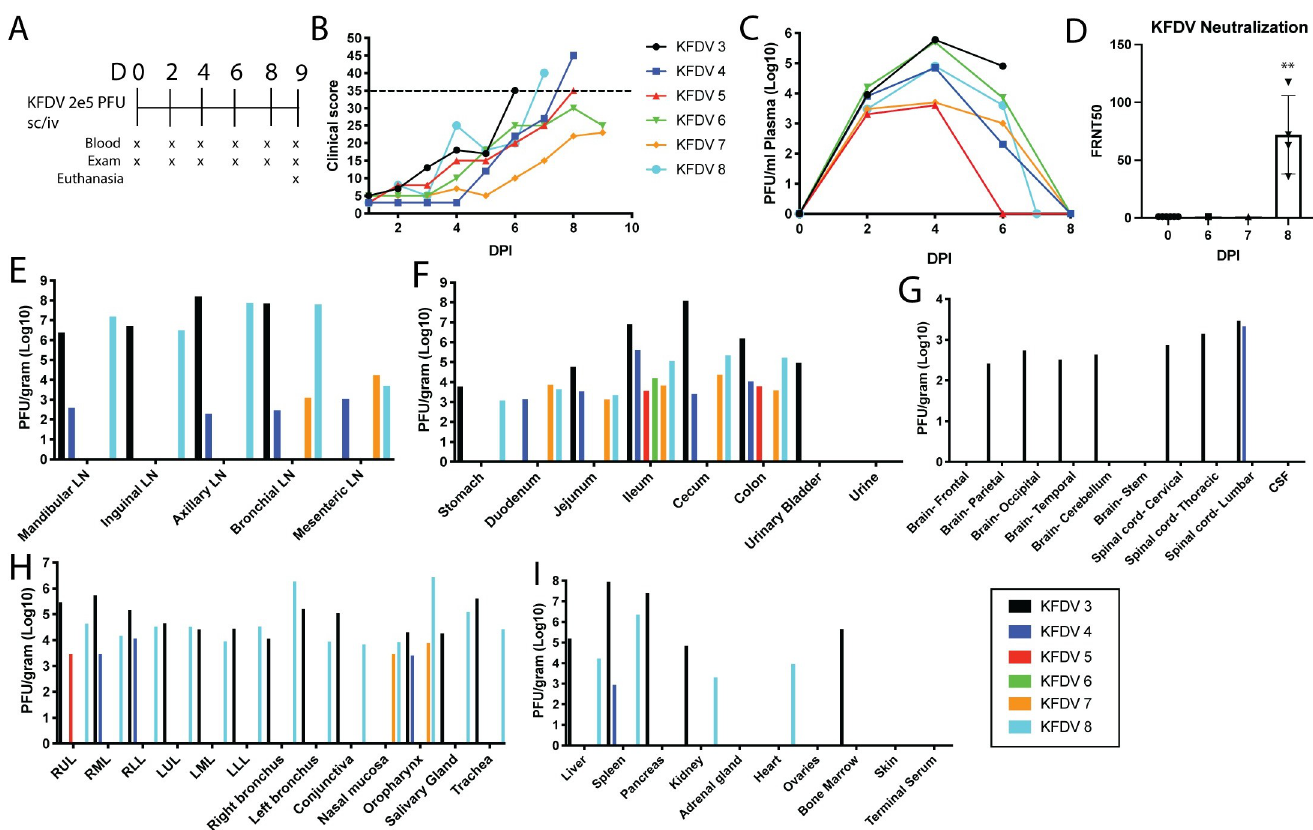
Fig 1. KFDV causes moderate to severe clinical illness in pigtailed macaques, and virus is present in multiple tissues. Six PTMs (KFDV 3–8) were infected with 2 x 10 5 pfu KFDV P9605 sc/iv (10 5 pfu, per route). A. Exam schedule following infection with KFDV. B. Animals were scored daily for clinical signs following infection. The dotted line indicates a score of 35. C. KFDV viremia was measured by limiting dilution plaque assay from plasma on the indicated days post infection. D. Neutralization assays were performed using heat-inactivated serum collected at 0, 6, 7, and 8 dpi by a focus reduction neutralization assay. FRNT50 values are reported. Error bars represent the standard deviation (SD) across four animals. Statistics were performed using an ordinary one-way ANOVA, comparing the FRNT50 values at D0 to D8 ( N = 4; �� P < 0.005). E-I. At terminal endpoints, or 9 dpi, animals were euthanized and virus was isolated from various tissues by plaque assay. Plaque counts were normalized to 1 gram of tissue. Data from each individual animal are